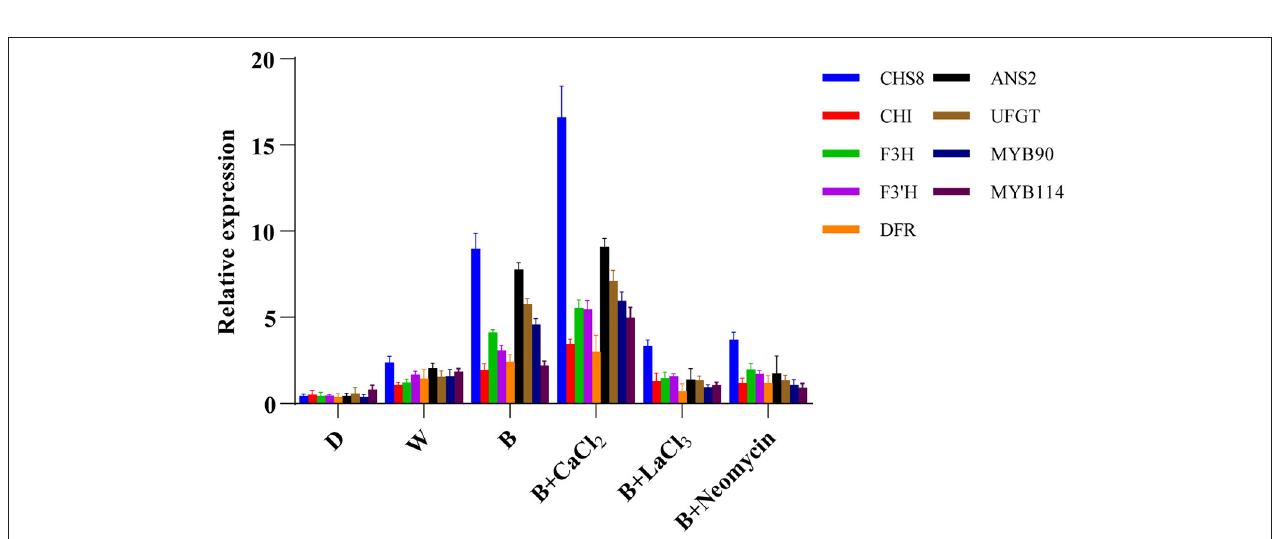
FIGURE 5 | Expression level of genes related to anthocyanin biosynthesis at 24h in “Dongnong 690” hypocotyls under different conditions. Values are the mean ± SE of triplicate ( n = 3). The different treatments were as follows: (1) D: cultivated with purified water without light; (2) W: cultivated with purified water under white light radiation; (3) B: cultivated with purified water under blue light radiation; (4) B + CaCl 2 : cultivated with 3mM CaCl 2 under blue light radiation; (5) B + LaCl 3 : cultivated with 1mM LaCl 3 under blue light radiation; and (6) B + neomycin: cultivated with 1mM neomycin under blue light